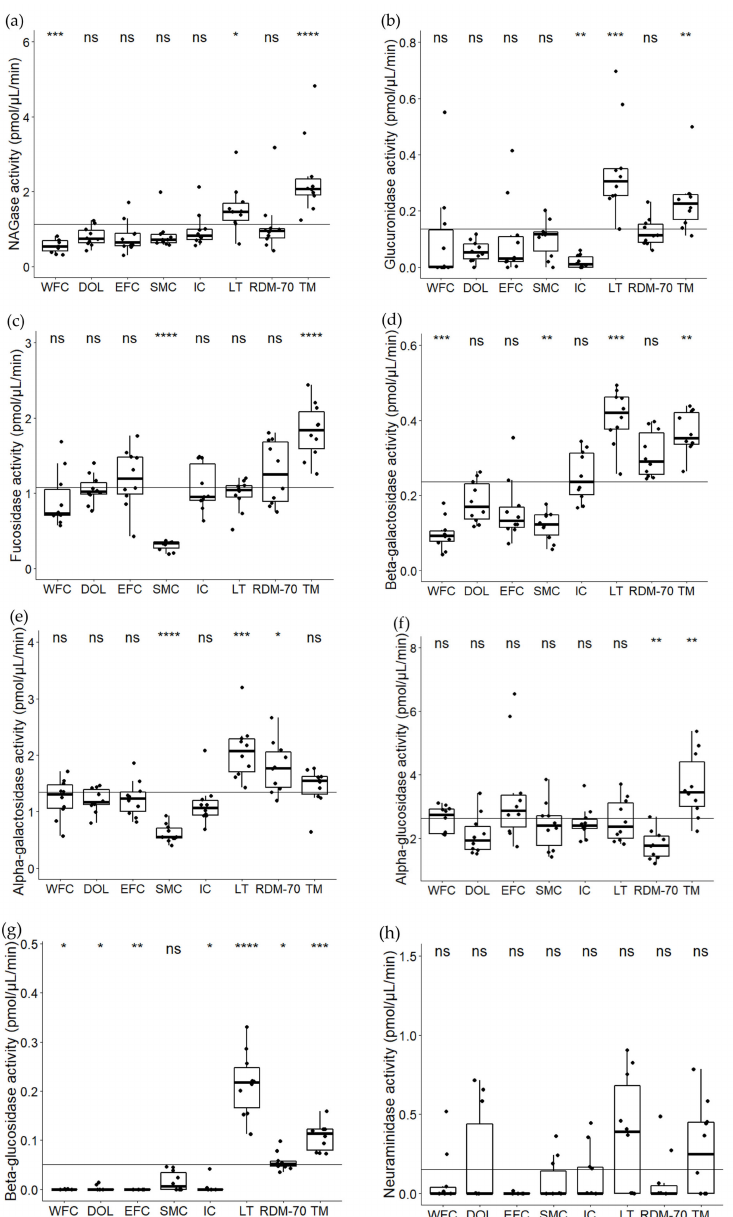
Figure 1. Glycosidase activities of ( a ) N -acetyl- β -glucosaminidase (NAGase), ( b ) β -glucuronidase, ( c ) α -fucosidase, ( d ) β -galactosidase, ( e ) α -galactosidase, ( f ) α -glucosidase, ( g ) β -glucosidase and ( h ) N -acetyl- α -neuraminidase, in milk from Western Finncattle (WFC), Norwegian Doela cattle (DOL), Eastern Finncattle (EFC), Swedish Mountain cattle (SMC), Icelandic cattle (IC), native Lithuania Black and White cattle (LT), Danish Red anno 1970 (RDM-70) and Norwegian Telemark cattle (TM). The horizontal line in each box indicates the median and the overall horizontal line indicates the mean of all samples in the study. Stars indicate significant differences from the overall mean: * p < 0.05, ** p < 0.01, *** p < 0.001, **** p < 0.0001, ns = not